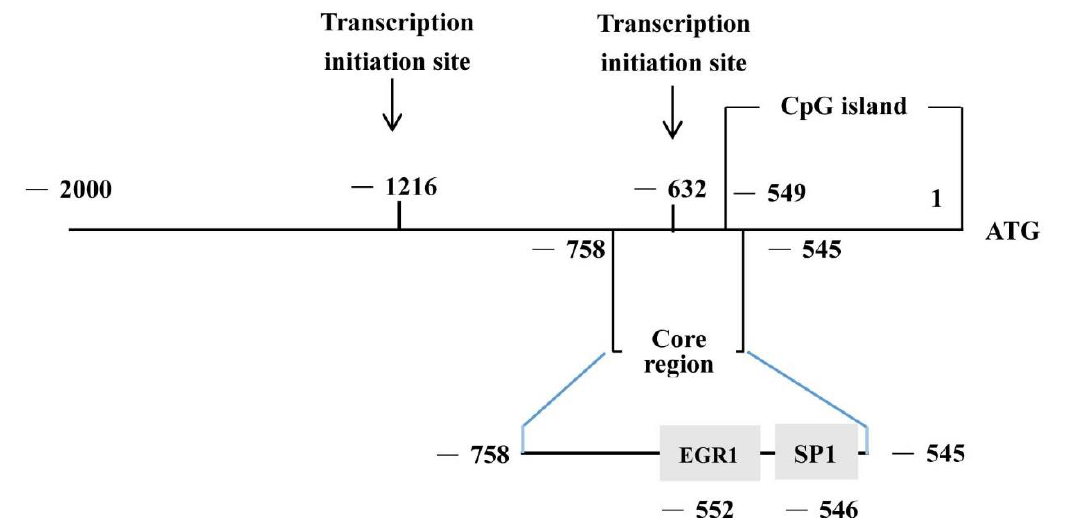
Figure 7. Schematic diagram of the BMP7 promoter structure of from Hu sheep.